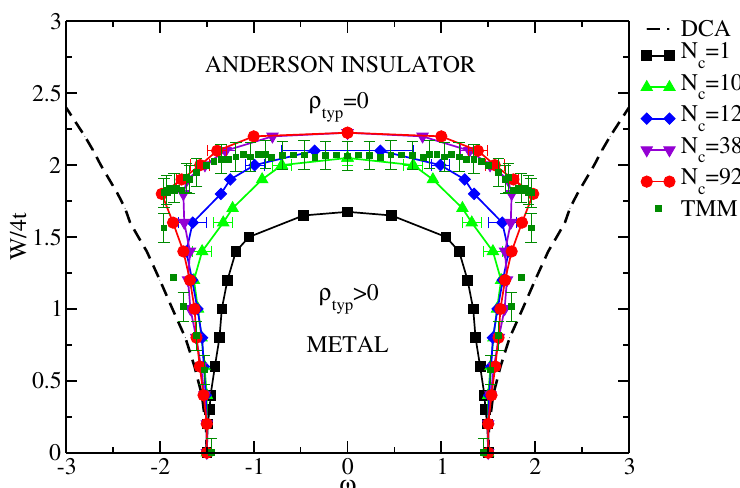
Figure 31. Phase diagram of the Anderson localization transition in 3D obtained from TMDCA simulations. As N c increases, a systematic improvement of the trajectory of the mobility edge is achieved. At large enough N c and within computation error, our results converge to those determined by the TMM [209].